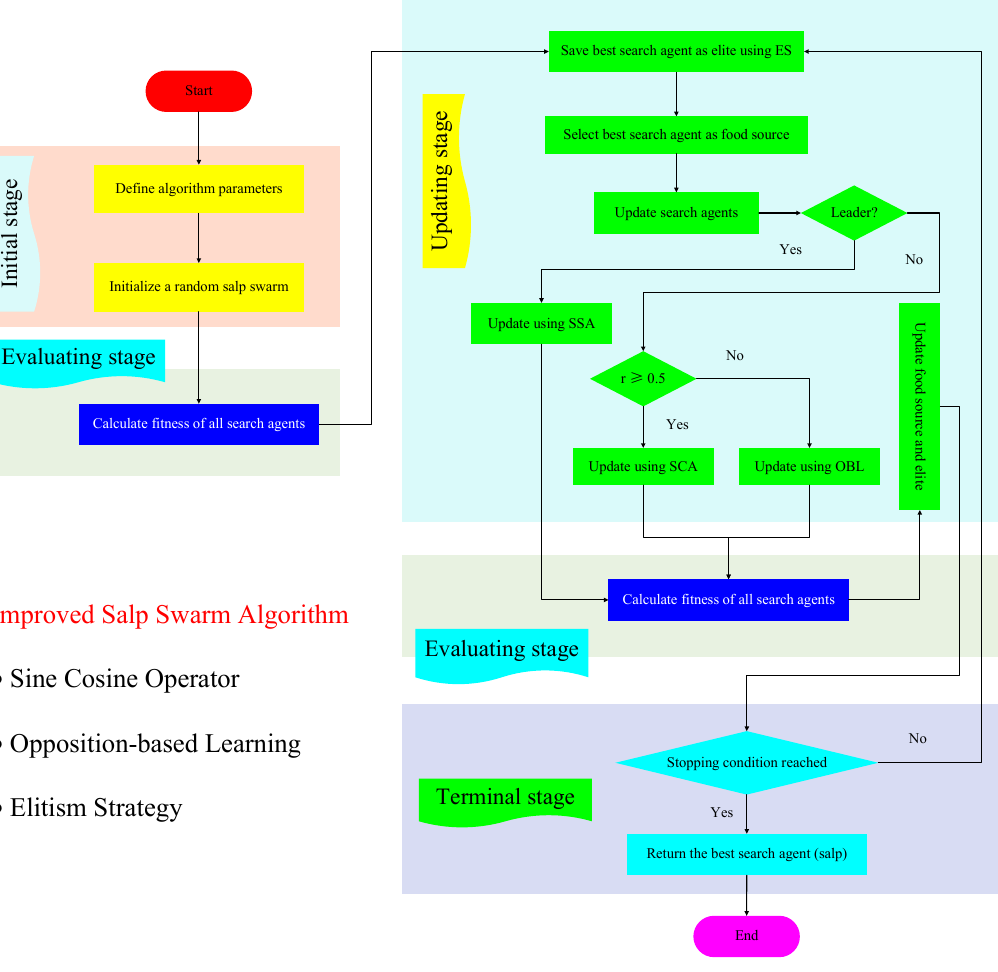
Figure 2. Framework of the ISSA algorithm.